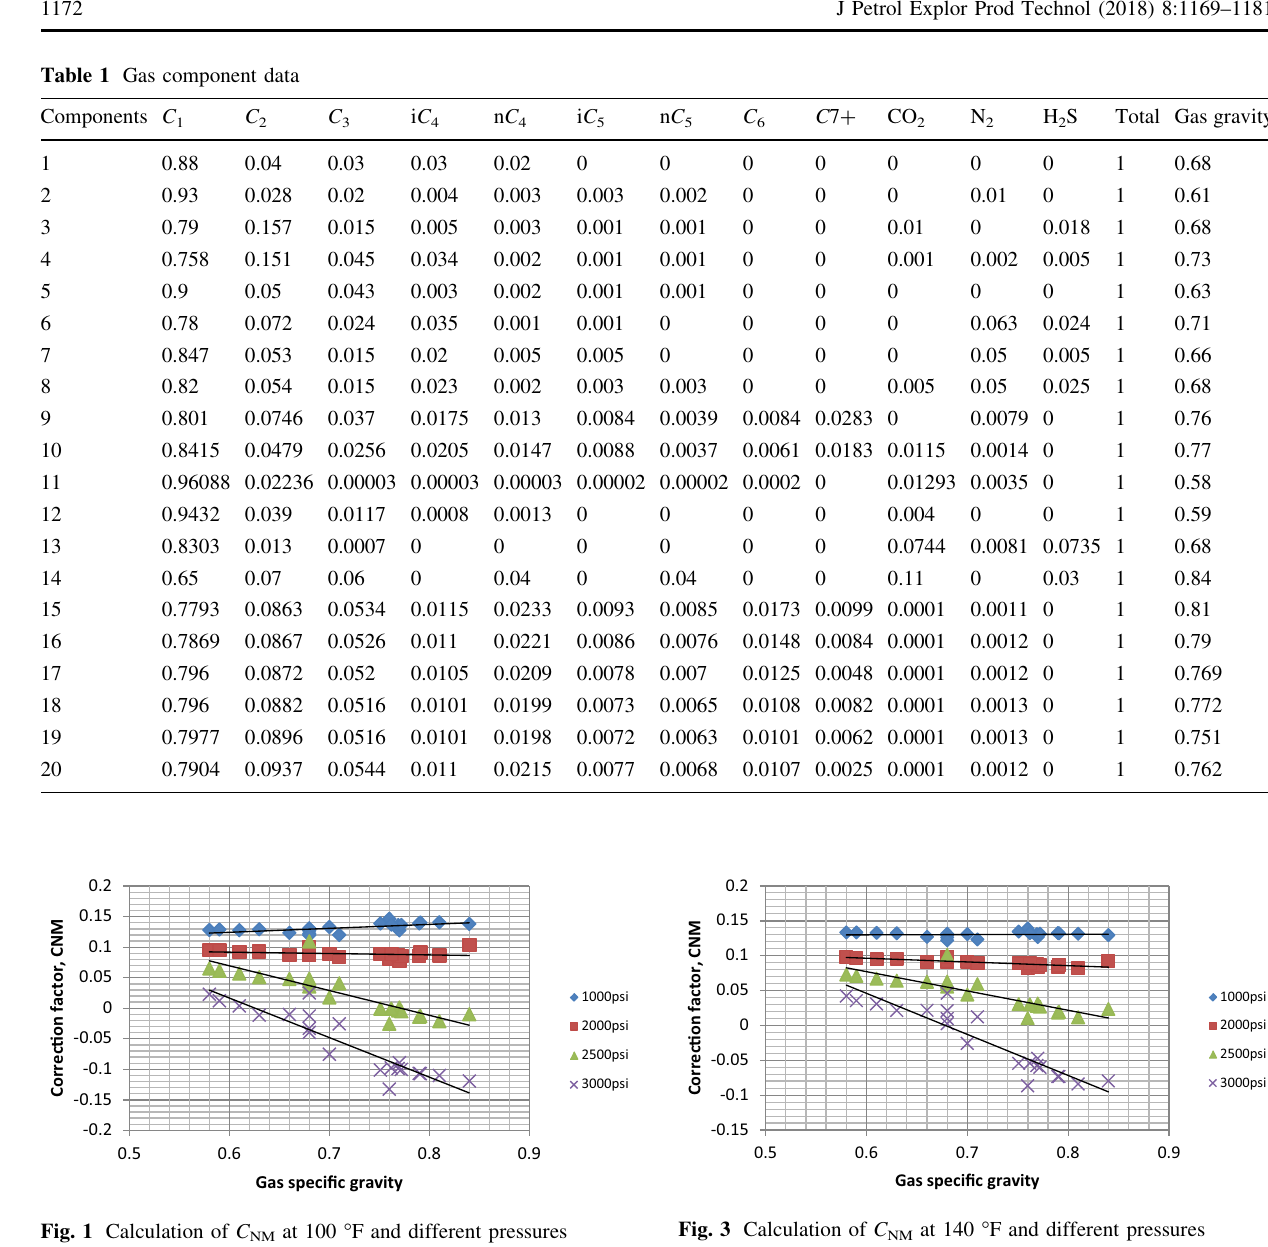
Fig. 1 Calculation of C NM at 100 (cid:3) F and different pressures